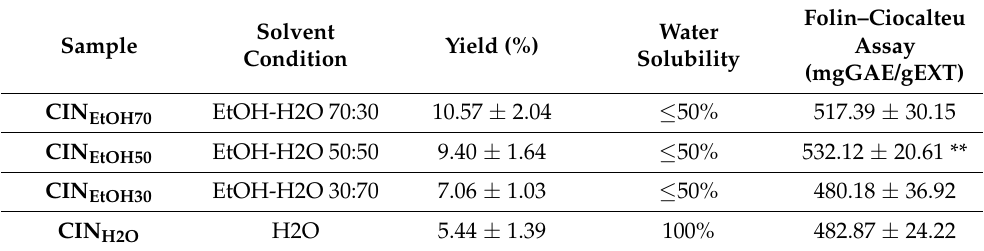
Table 1. Comparison between Folin–Ciocalteu assay among different Cinnamomum extract. The statistical analysis was carried out comparing water extraction conditions against other solvent ratios in the recovery of phenols